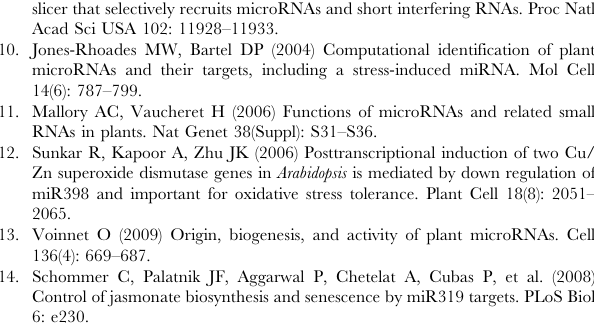
Table S7 Primers used in this